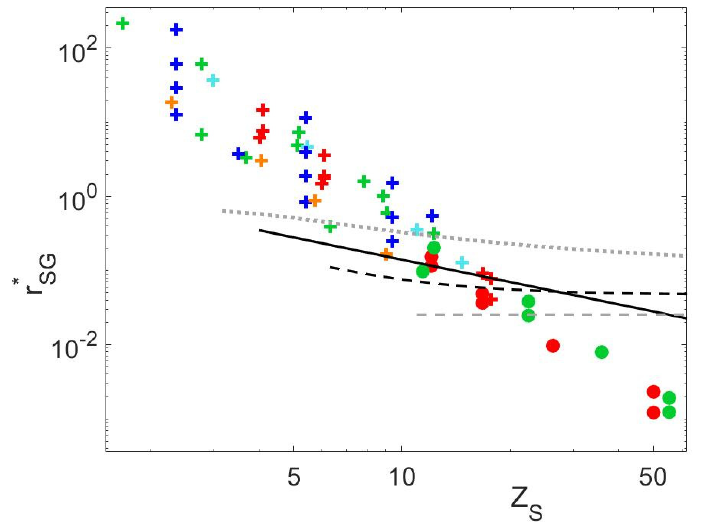
Figure 12. r ∗ for all PS (green), PI (red), PMMA (orange) and PBD (blue) blends available in this study and in the literature. The + and ○ symbols correspond to the data for which full CRR-like motion are observed or not, respectively. The data are compared to the critical value of r ∗ proposed by Park and Larson [19] (Equation (27) –dotted grey line), and by Read et al. [4] (dashed grey line). Furthermore, critical values based on Equation (30) (dashed black line), or based on Equation (31) (continuous black line) are given.